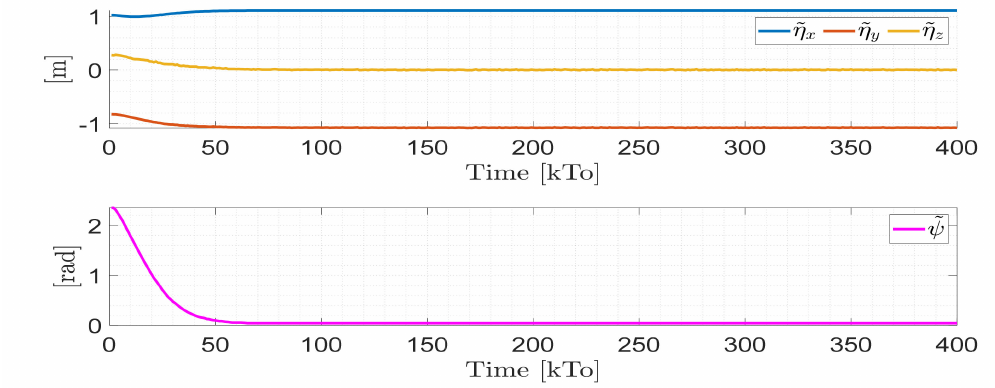
Figure 17. Time evolution of the control errors ˜ η ( kT 0 ) = ( ˜ η x , ˜ η y , ˜ η z , ˜ ψ